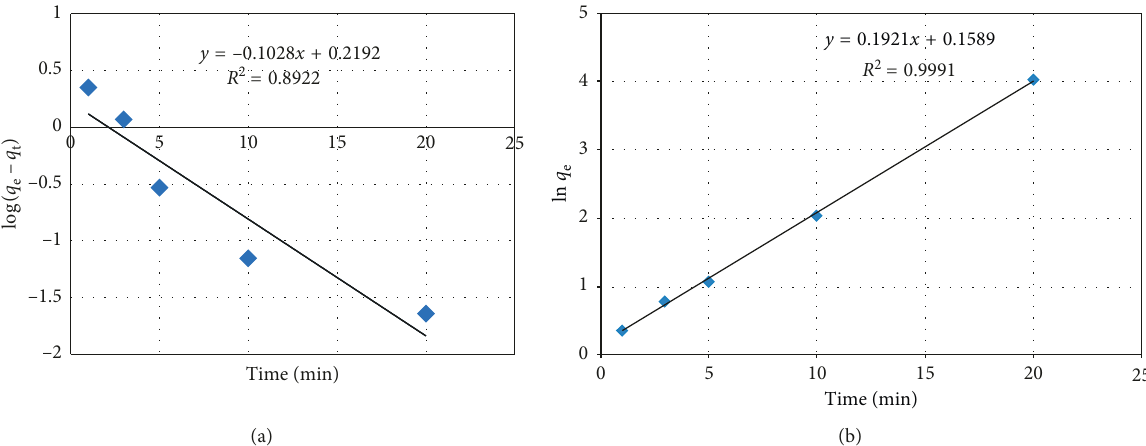
Figure 12: Outline of the mechanism underlying the adsorption of EBT dye onto the NSG nanocomposite.